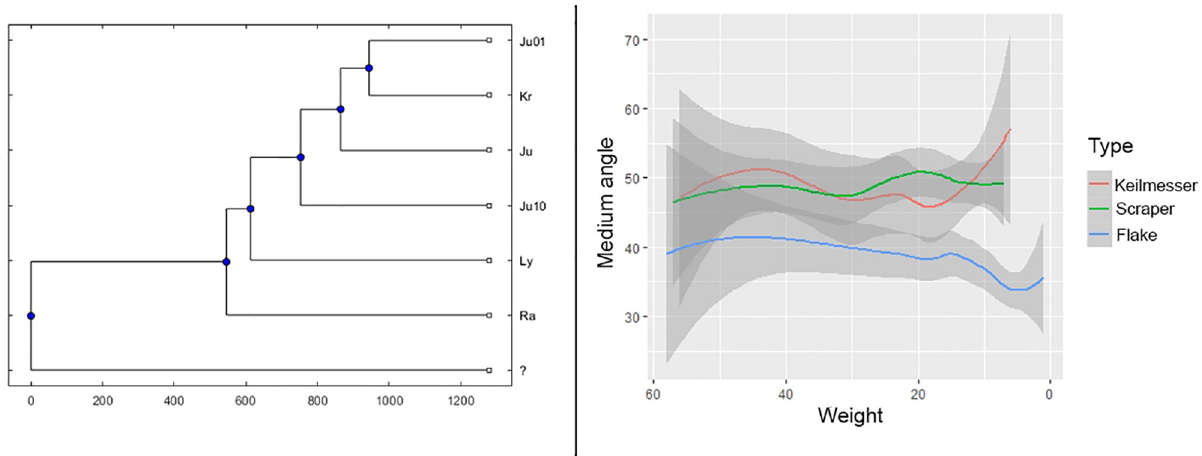
Fig 21. On the left, group distance for raw material showing differences between the different varieties of Jurahornstein ; on the right, distribution of the cutting edge angles according to the weigth diminution (“Ju”, “Ju01” and “Ju10”: Jurahornstein; “Kr”: Cretaceous chert and quartzite; “Ra”: Radiolarite; “Ly”: